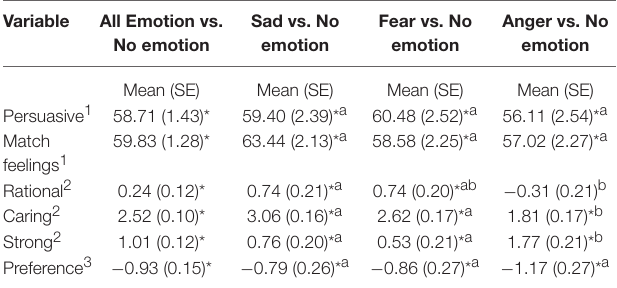
TABLE 1 | Average perceptions of emotional messages compared to the non-emotional message. Variable All Emotion vs. Sad vs. No Fear vs. No Anger vs. No No emotion emotion emotion